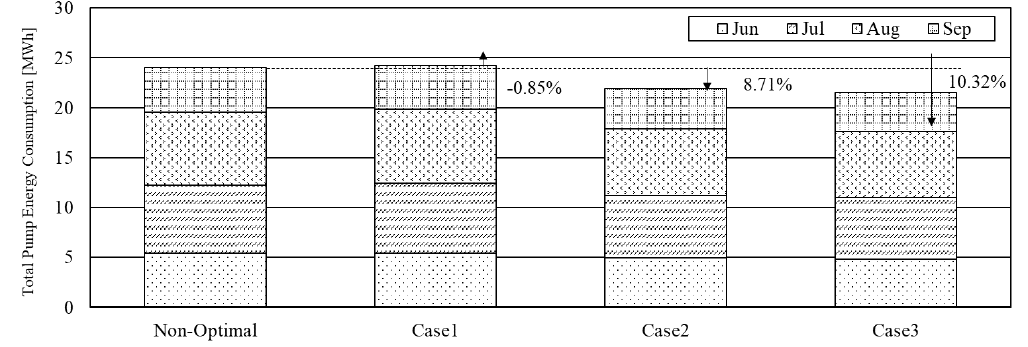
Figure 12. Comparison of pump energy consumption between normal operation mode and optimal operation modes for June through September.